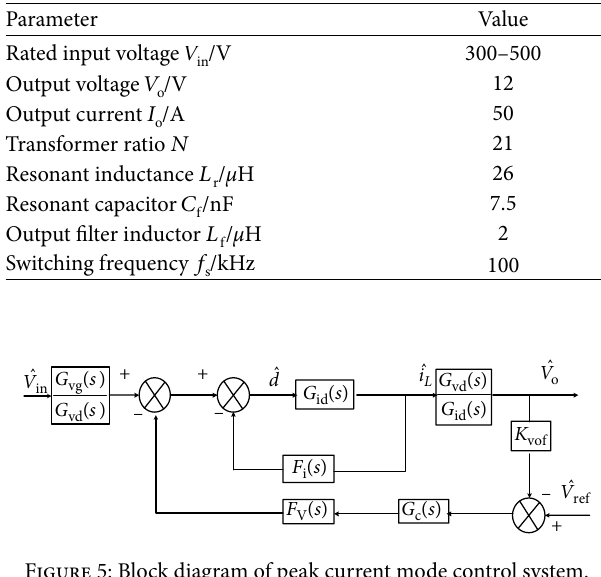
Figure 5: Block diagram of peak current mode control system.